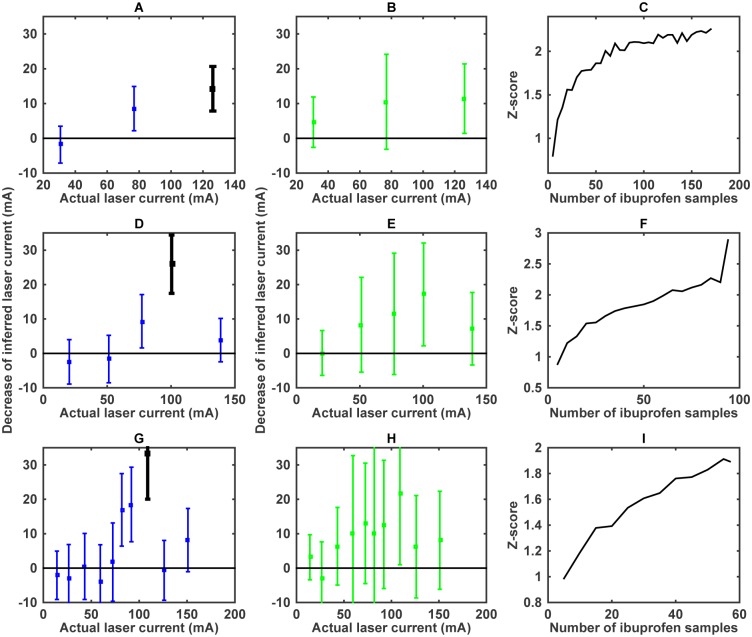
Perceived stimulus level decrease due to treatments.(A) Differences of the inferred laser current between the control and the ibuprofen datasets, ΔIibuprofen. Errors represent standard deviations, estimated with bootstrapping. (B) Similar differences for the mutant worm, ΔImutant. Error bars are estimated by bootstrapping. (C) Dependence of the statistical significance of the perceived stimulus level reduction (measured by the Z score) for ibuprofen at 110 mA on the number of ibuprofen trials.